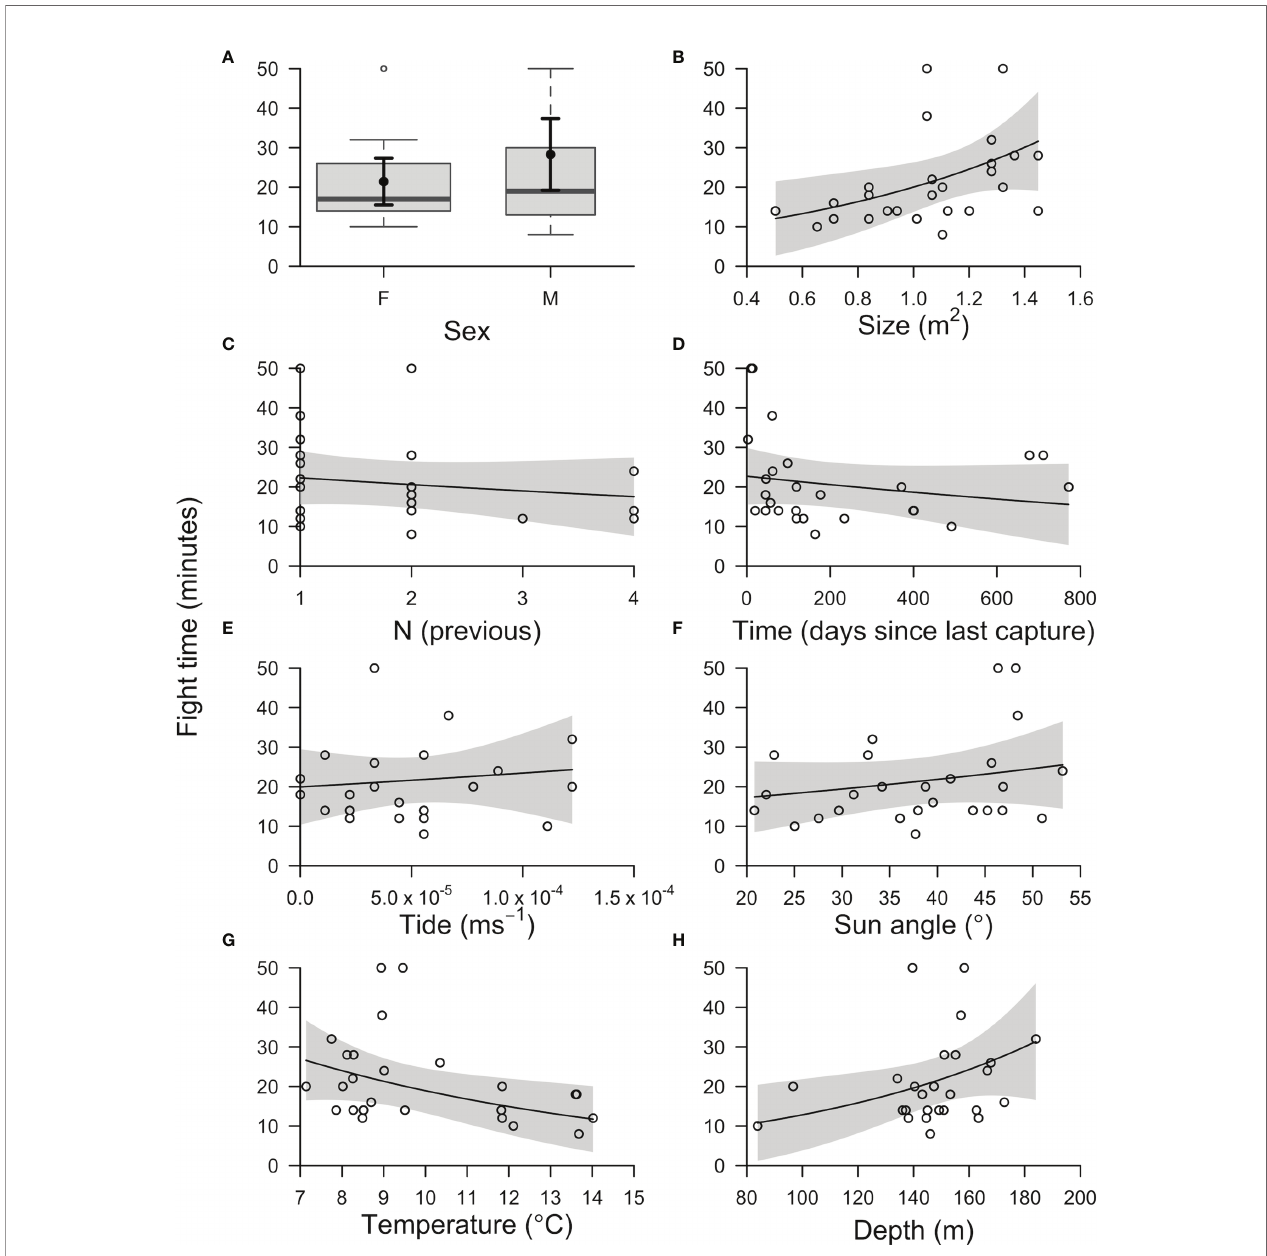
FIGURE 2 | The drivers of fi ght time during catch-and-release angling. Each plot shows the relationship between fi ght time and one of the following variables: (A) sex; (B) body size (dorsal surface area); (C) the number of previous capture events; (D) the number of days since the last capture event; (E) the strength of the tide; (F) the sun angle above the horizon (this is lowest early/late in the day/year and highest in the middle of the day/year); (G) the water temperature; and (H) the depth. In (A) boxplot width is proportional to the number of capture events of females (n = 18) and males (n = 8). The lower, middle and upper whiskers in grey represent the 25 th , 50 th and 75 th percentiles respectively. The black points and surrounding lines mark the mean ± 95% con fi dence intervals. In (B – H) the black lines and grey envelopes mark predictions and 95% con fi dence intervals from a generalised linear model of fi ght time, with other variables held at their median values. Note that relationships are shown for all variables in the model but none of the terms in the model were statistically signi fi cant at the 0.05 level ( Table S3